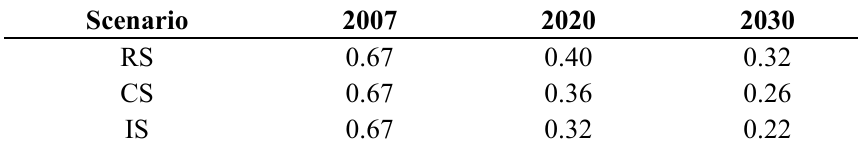
Table 4. Final energy consumption intensity for the RS, CS, and IS (units: tce/10,000 yuan).